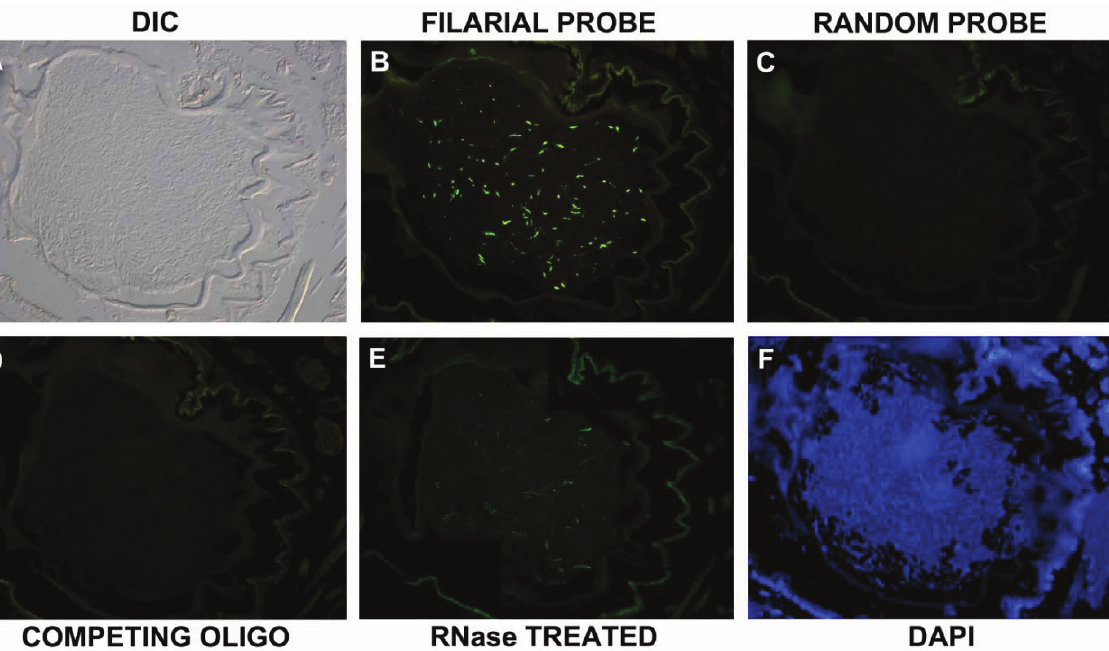
Figure 1. Representative image of an in situ hybridization experiment using Onchocercidae family filarial nematode specific probe (18S/5.8S internal transcribed spacer sequence) on whole mount tick consecutive sections. Panel A and Panel F show the structure and the nuclei of the tissue using differential interphase microscopy (DIC) and DAPI staining (blue staining) respectively. Panel B show the filarial specific probe staining (bright green staining) while Panels C–E show different control experiments: Panel C = random probe, Panel D = competing oligonucleotide and Panel D = RNase treated sections). 400×